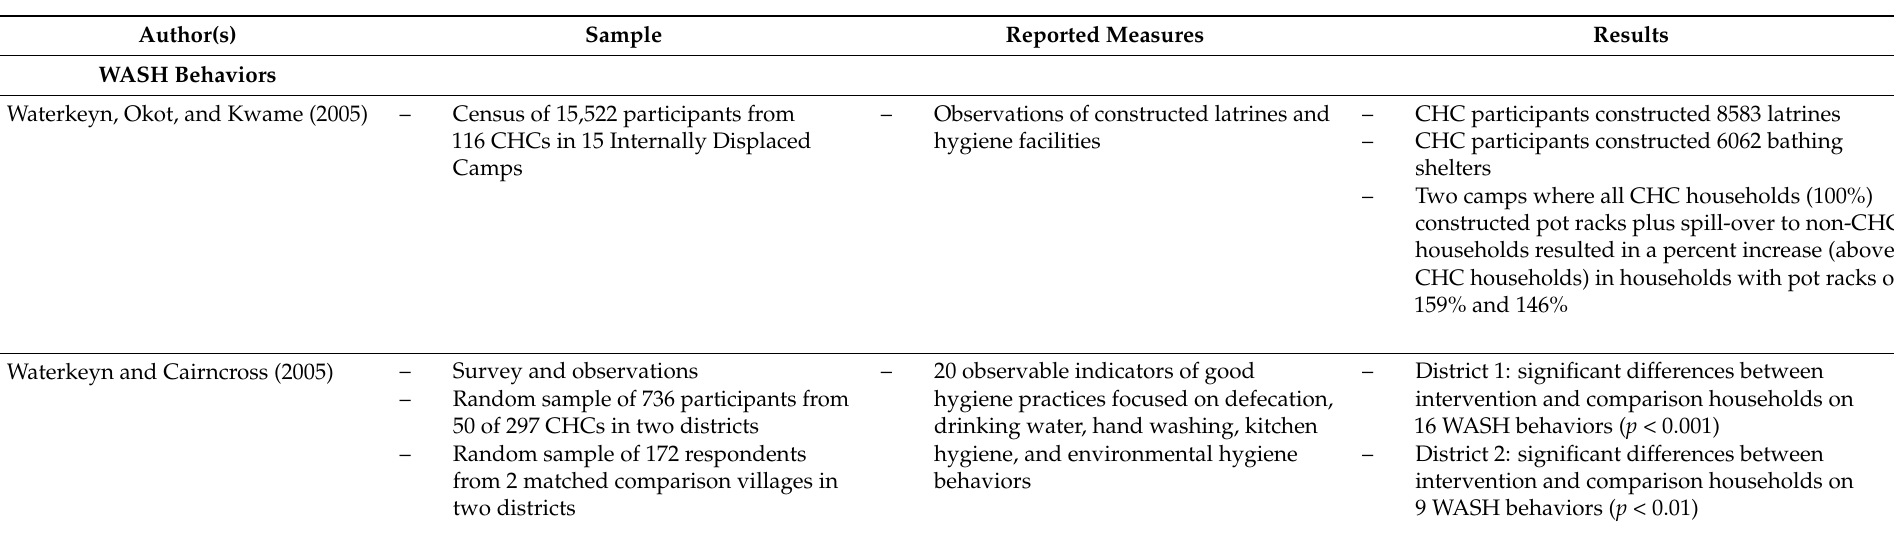
Table 3. Samples, measures, and results of reviewed